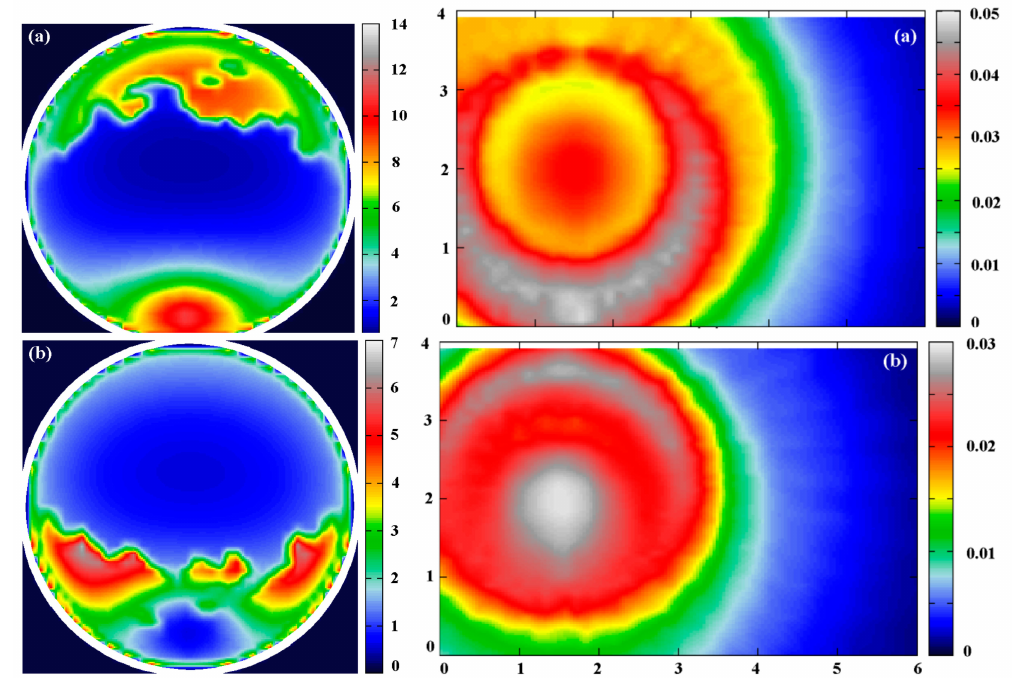
Figure 5. Sky luminance distribution in kcd.m − 2 (left plots) and work plane illuminance in klx (right plots) for clouds clumped about the azimuth angle at 0 ◦ ( a ) and 180 ◦ ( b ) with an o ff set of 2.0 km. Solar altitude is 20 ◦ , and the cloud fraction is 0.3. Room dimensions are in meters (see plots on right side of the